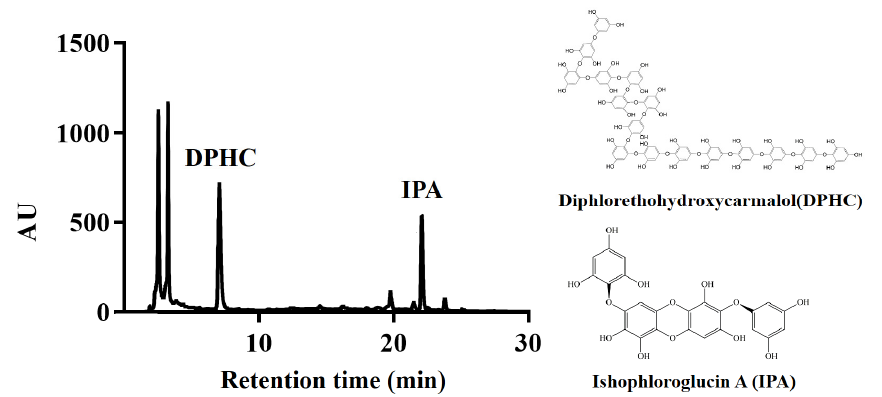
Figure 1. HPLC chromatogram of Ishige okamurae extract. It was confirmed that Ishige okamurae 50% ethanol ( v / v ) extract contained two phlorotannin compounds diphlorethohydroxycarmalol (DPHC) and ishophloroglucin A (IPA), which were identified.